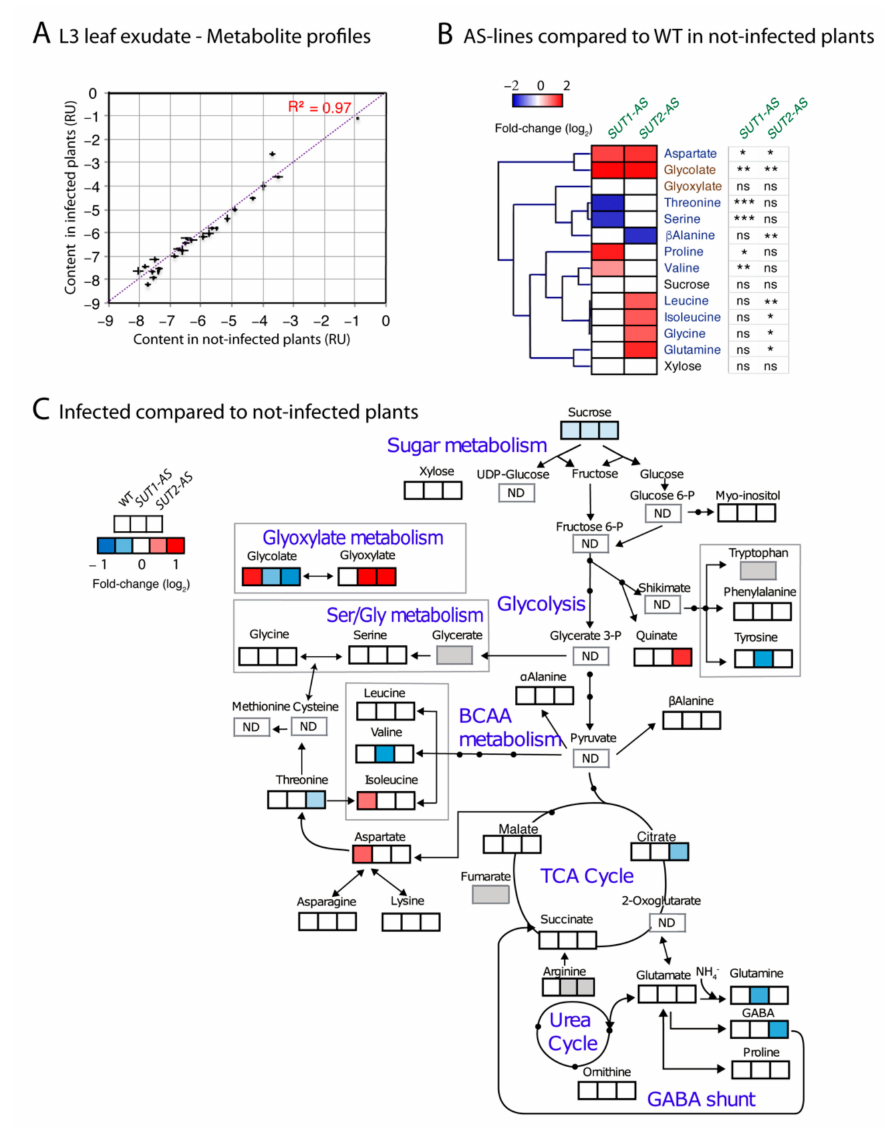
Figure 7. Comparison of metabolite profiles of the phloem sap-enriched exudate from the L3 leaf of not infected and infected plants. ( A , B , C ) Analysis of the metabolite content determined on the exudate of the third leaf for WT, SUT1- and SUT2 -AS lines. ( A ) Pairwise comparisons and R 2 correlation coefficients between metabolite profiles in infected and not infected plants in the 3 genotypes. The plots show for each metabolite its contents in the exudates of not infected plants ( X -axis) and infected plants ( Y -axis). The linear regression indicates that most metabolites remained stable in both conditions. ( B ) Heat map showing significant fold changes in metabolite contents in the phloem sap-enriched exudates from the L3 leaves of not infected SUT1 - and SUT2 -AS plants compared to not infected WT plants ( n = 7–8). Values are shown in a blue-to-red log 2 scale, with blue for negative values, red for positive values and white for no difference. On the right panel: significance of the effects due to genotype (G), determined using one-way ANOVA (* p < 0.05, ** p < 0.01 and *** p < 0.001; ns, not significant). ( C ) Heat map showing significant fold changes in the contents of metabolites in phloem sap-enriched exudates in response to infection ( p -value < 0.05 on a paired t -test). From the left to the right sides, responses in wild-type (WT) on the left side, SUT1- AS line in the middle and SUT2 -AS line on the right side. Values are shown in a blue-to-red log 2 scale, with blue values for metabolites showing a smaller content (and red values for higher) due to infection. BCAA: branched-chain amino acids. TCA: tricarboxylic acid cycle. In white: nonsignificant variations. In grey: missing